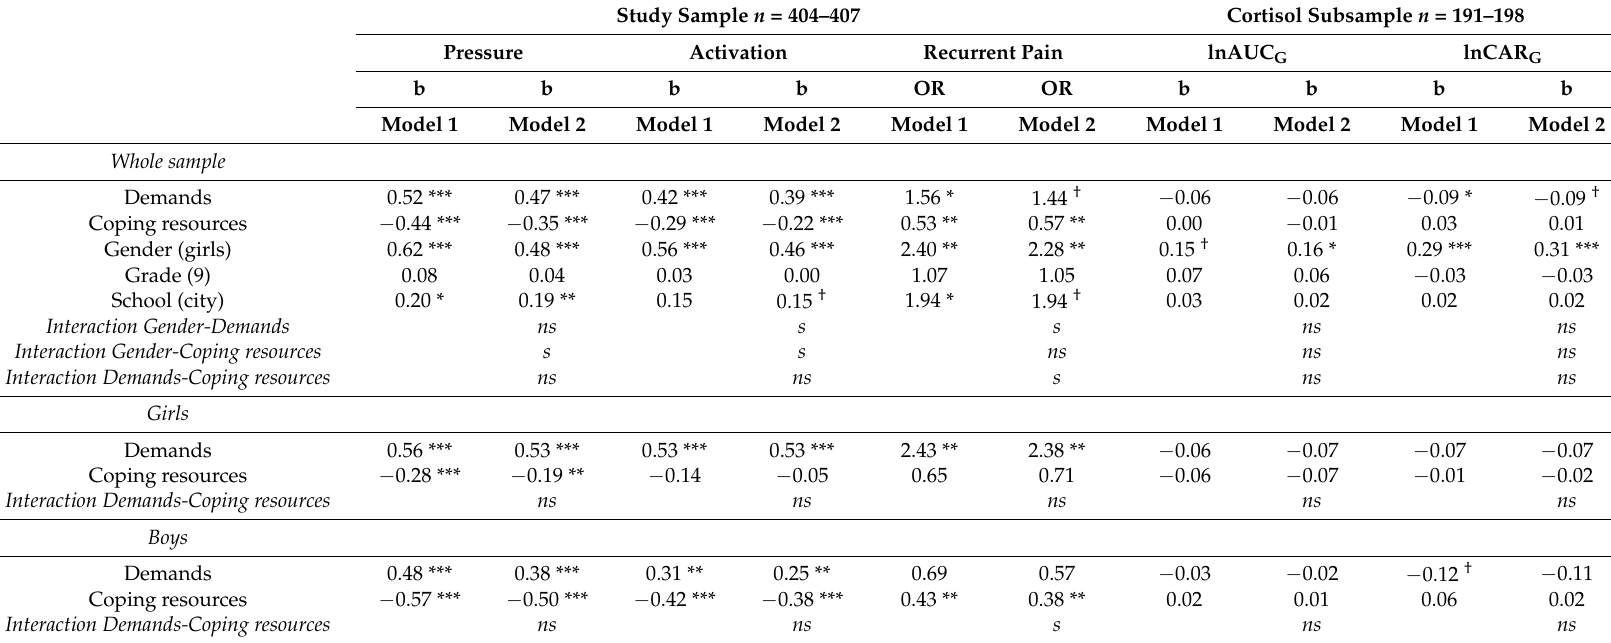
Table 2. Results from linear (OLS) regressions of pressure, activation and cortisol output, and from binary logistic regressions of recurrent pain, by demands and coping resources in